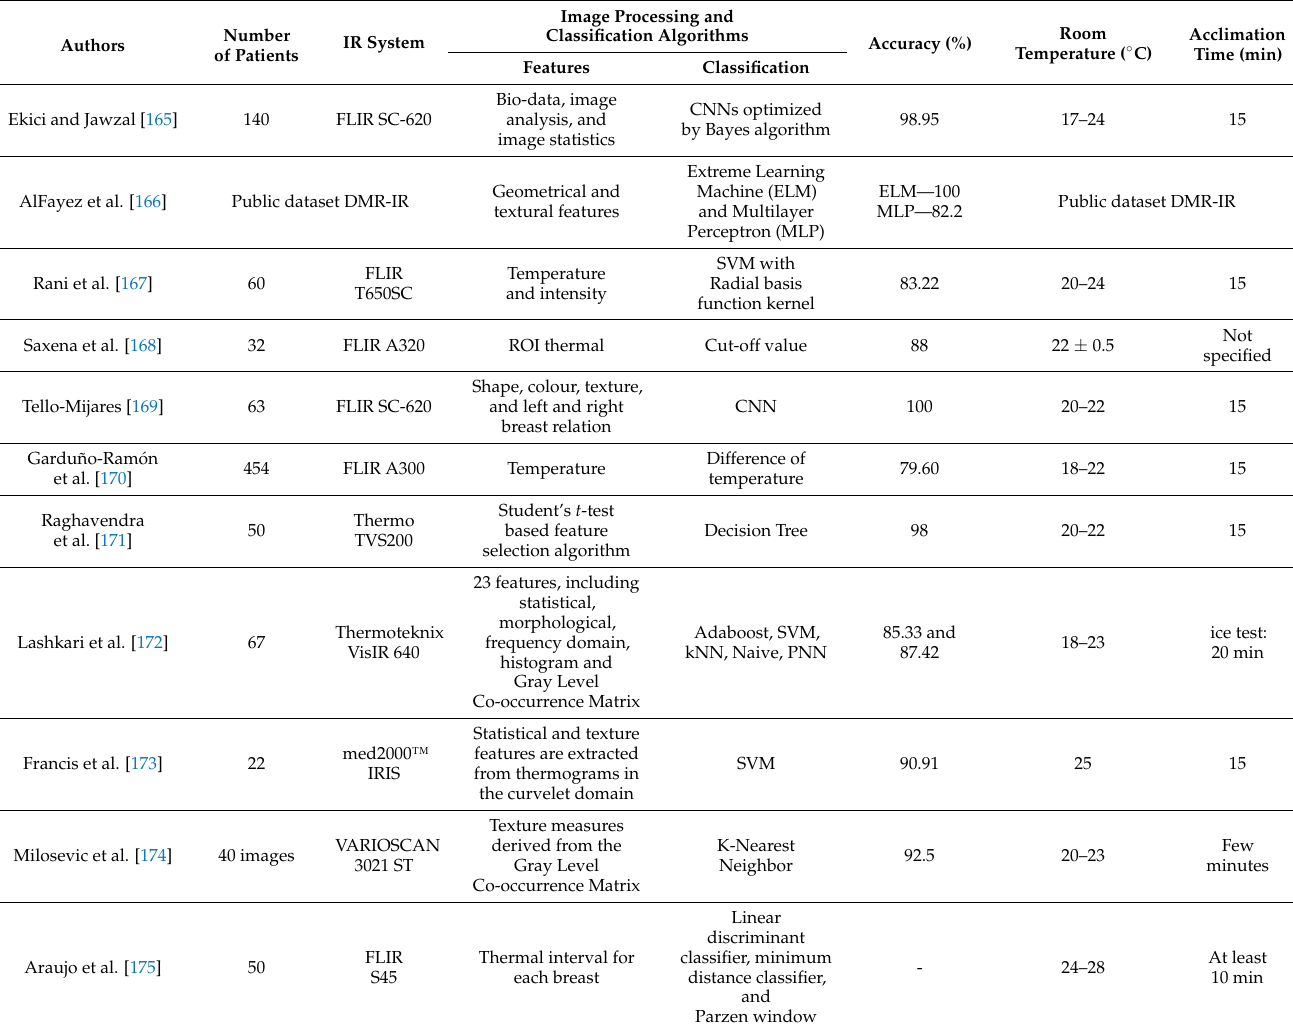
Table 3. Summary of the breast lesions detection using infrared